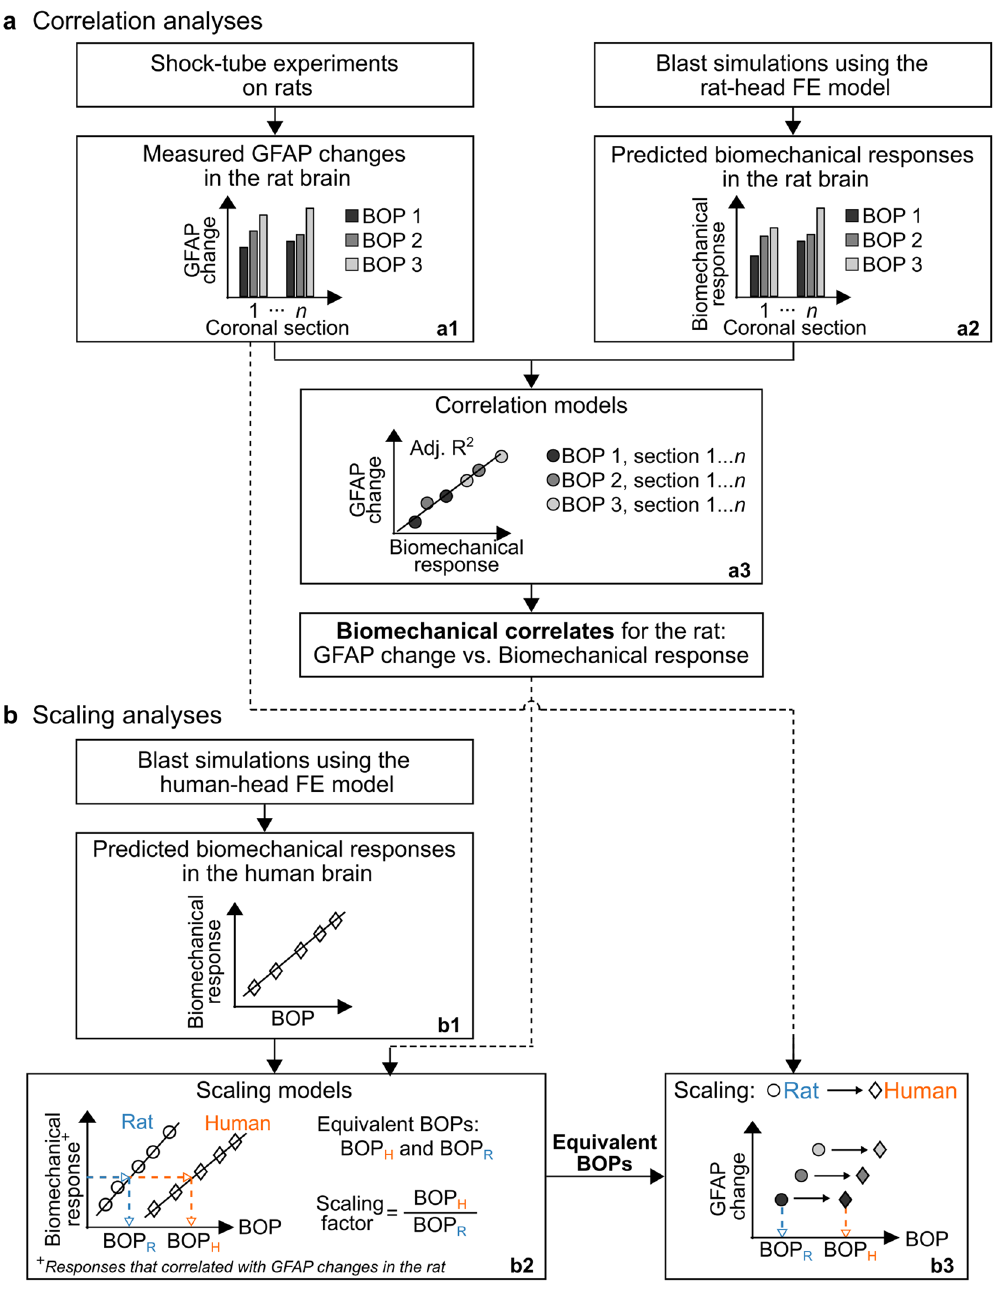
Figure 1. Flowchart of the biomechanical-based methodology to scale blast-induced molecular changes in the rat brain to the human brain. ( a ) Correlation analyses. We performed single shock-tube exposures on rats at different incident blast overpressures (BOPs) and characterized the brain-tissue changes in glial fibrillary acidic protein (GFAP) resulting from the blast-wave exposures ( a1 ). Then, using a high-fidelity finite-element (FE) model of a rat head, we conducted blast simulations at the same BOPs as those of the experiments and computed the biomechanical responses (i.e., intracranial pressure, von Mises stress, maximum principal strain, and strain rate) in the rat brain ( a2 ). Using the experimental and simulation data, we developed correlation models to identify correlates between the biomechanical responses and GFAP changes ( a3 ). We performed these analyses for three brain regions: corpus callosum, hippocampus, and brainstem. ( b ) Scaling analyses. Using a high-fidelity FE model of a human head, we performed blast simulations at different BOPs and computed the biomechanical responses in the brain tissues ( b1 ). Next, using the biomechanical correlates for the rat and the predicted responses